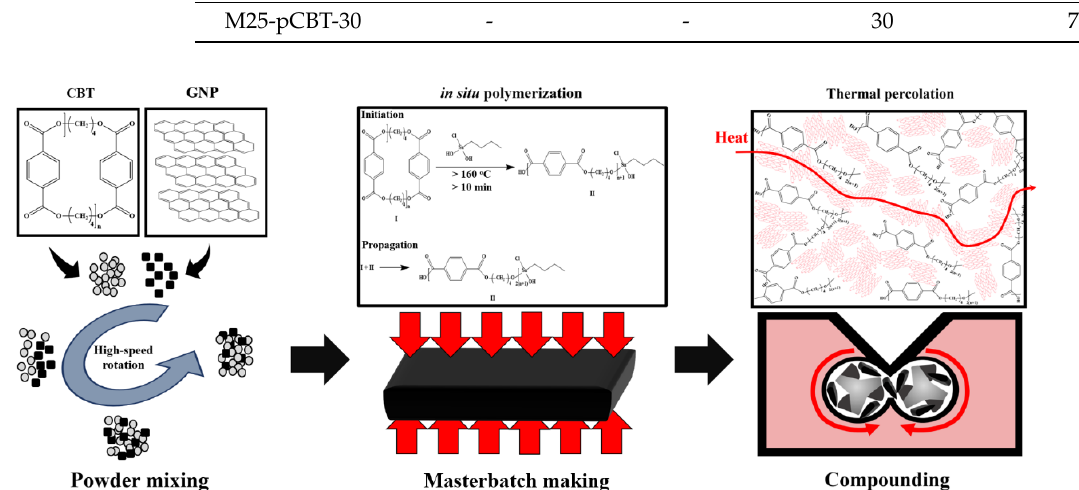
Figure 1. Schematic of composite fabrication using the proposed